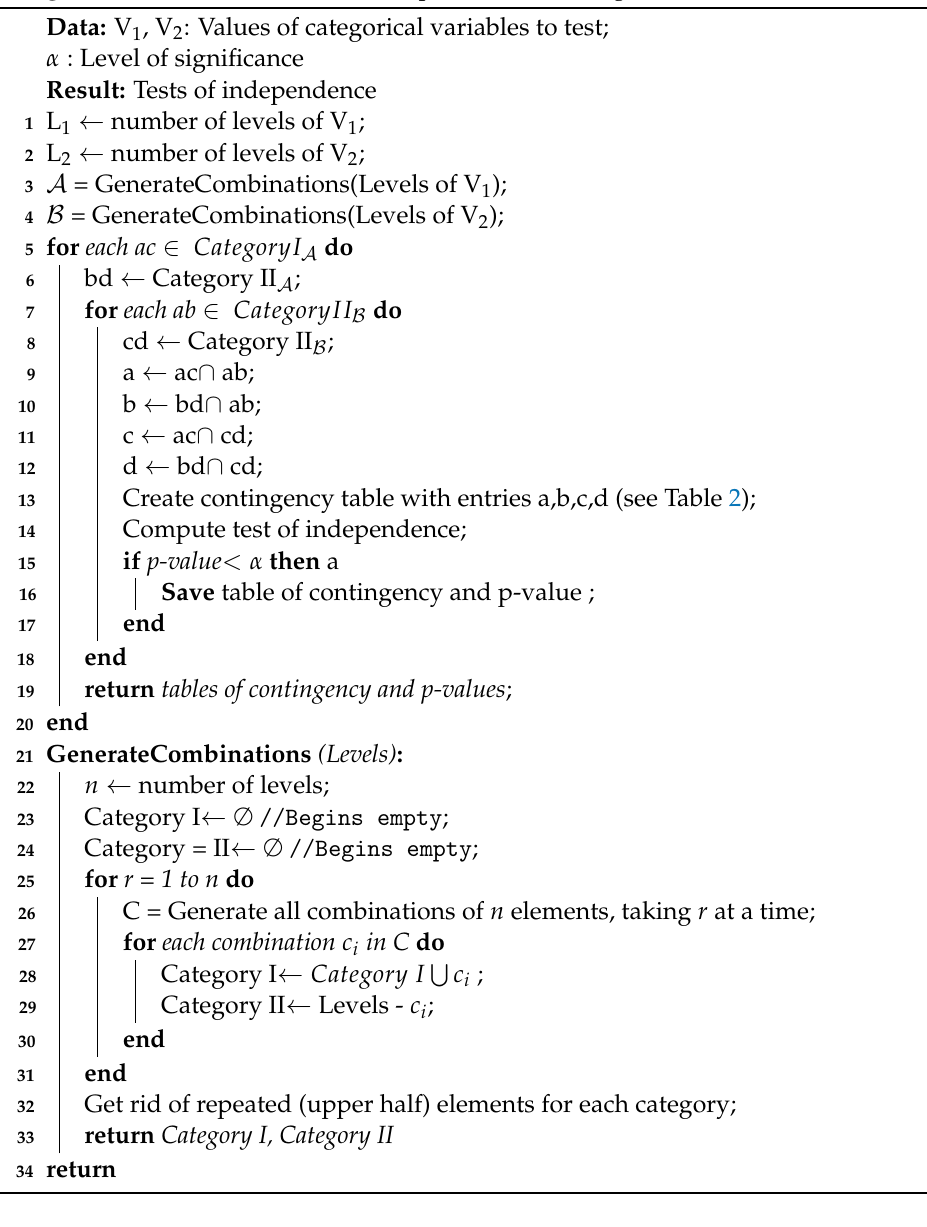
Algorithm 1: Exhaustive test of independence for categorical